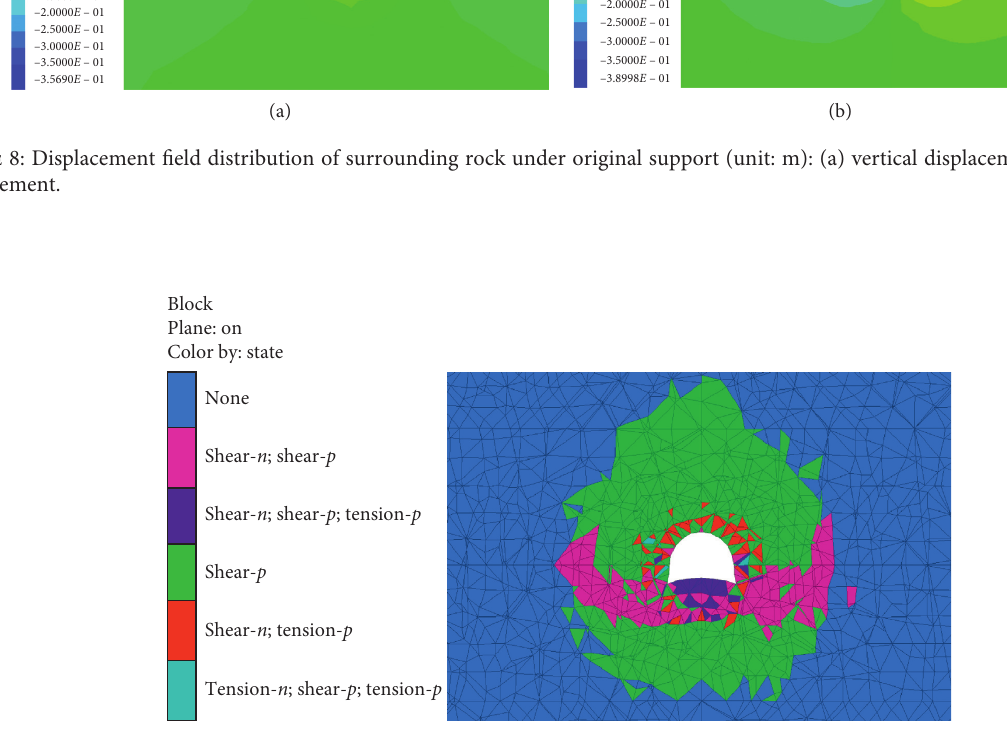
Figure 9: Plastic zone distribution of surrounding rock under original